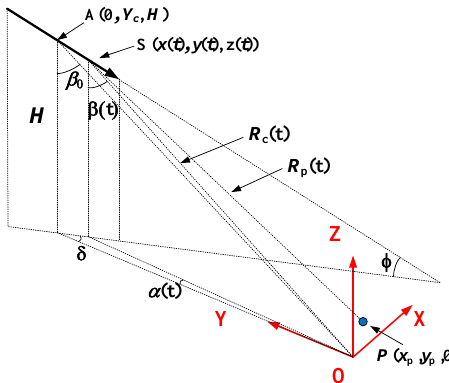
Figure 1. Extremely-high-squint SAR